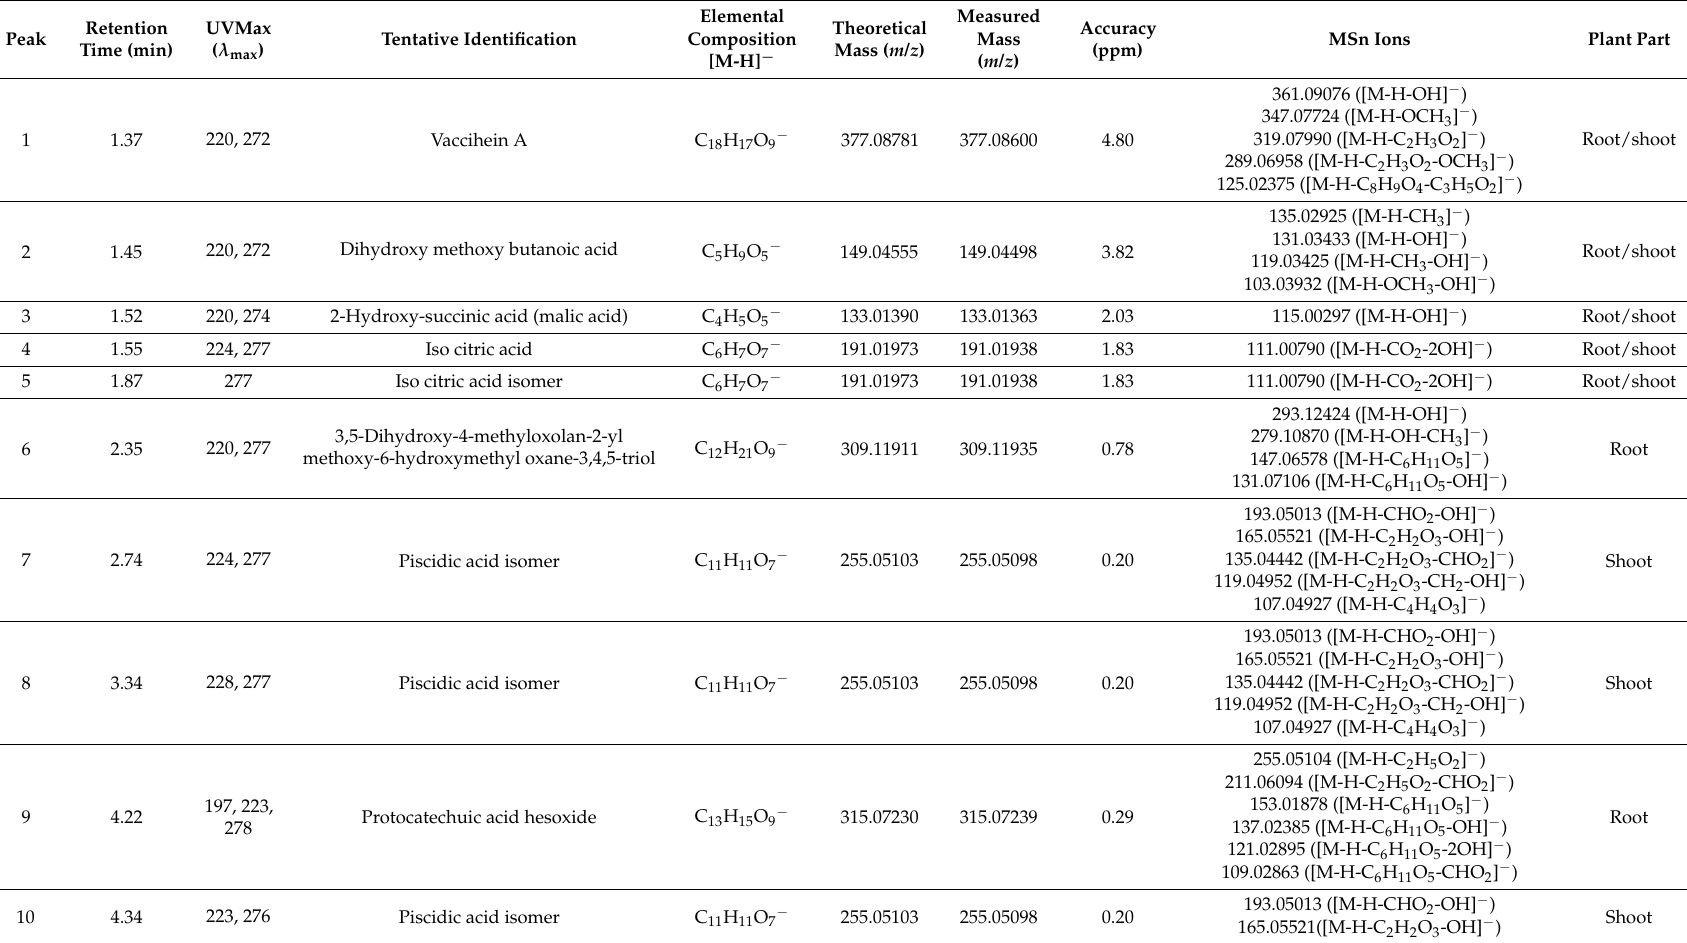
Table 1. Metabolites identified in aerial and radicular parts of Coryphantha macromeris by ultra-high-performance liquid chromatography–tandem mass spectrometry (UHPLC-PDA-HESI-Orbitrap-MS/MS) data using heated electrospray ionization source (HESI) in negative ion